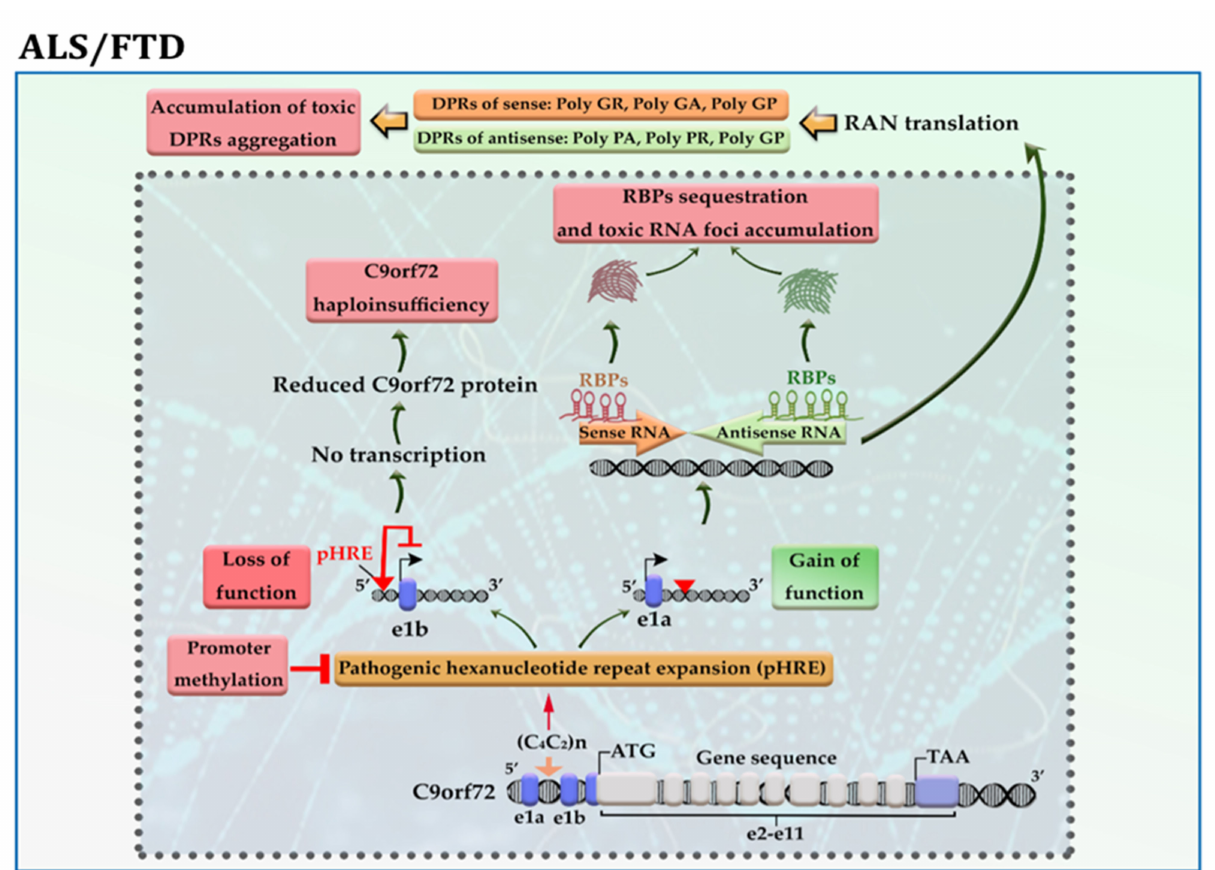
Figure 3. A schematic representation of the selected mechanisms in the pathogenesis of C9-ALS/FTD. Loss of function; the presence of pathogenic hexanucleotide G4C2 repeats expansion (pHRE) within the promoter region inhibits transcription processes and reduces C9orf72 protein levels. Gain of function; the presence of pHRE within intron 1 leads to the sequestration of RNA binding proteins (RBPs) and the accumulation of toxic RNA foci and dipeptide repeat proteins (DRPs). The promoter hypermethylation of the C9orf72 gene reduces the accumulation of RNA foci and/or DRPs aggregation in the neural cells. Amino acid abbreviations: A: alanine, R: arginine, G: glycine, and P: